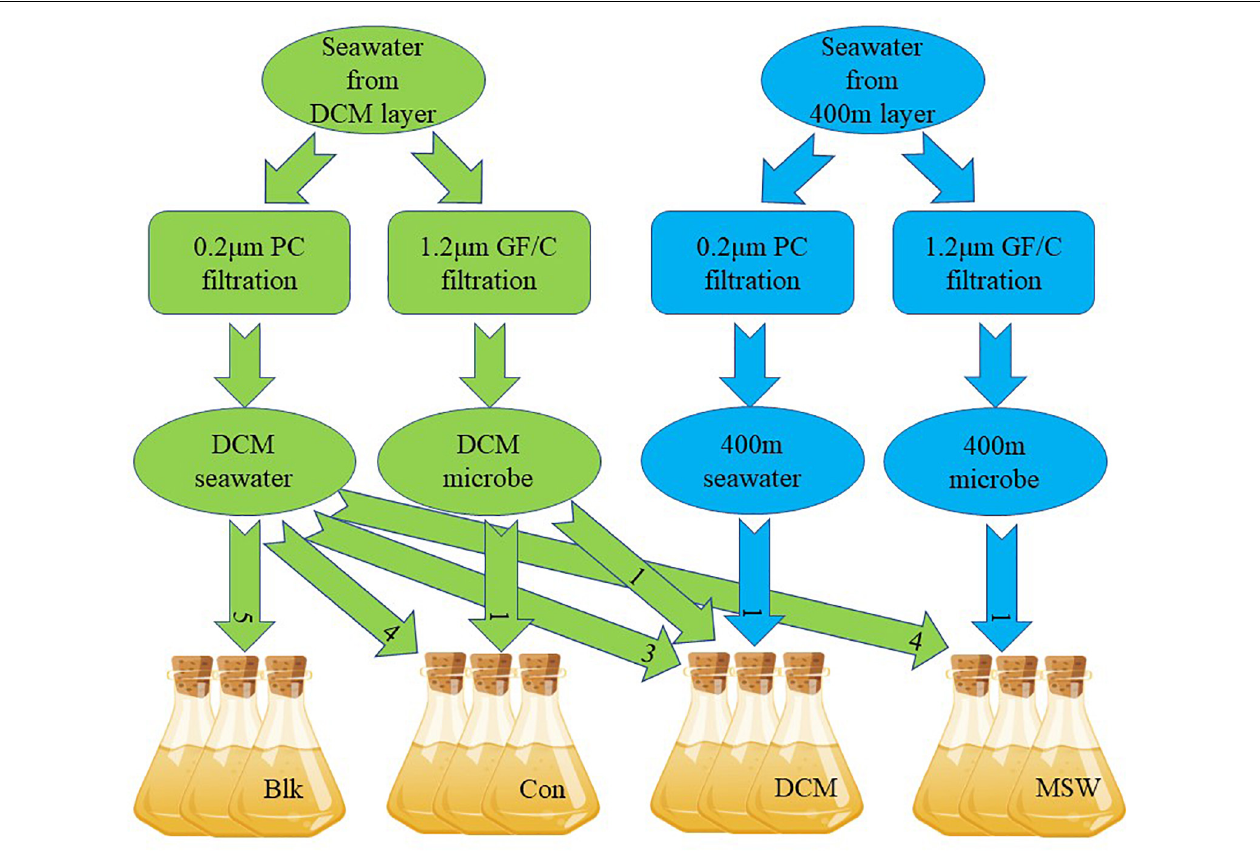
FIGURE 2 | Simulation of the water mixing cultivation experiment. DCM seawater means DCM seawater filtered through a 0.2 µ m polycarbonate filter, DCM microbe means DCM seawater filtered through a 1.2 µ m glass microfiber filter, 400 m seawater means 400 m seawater filtered through a 0.2 µ m polycarbonate filter, 400 m microbe means 400 m seawater filtered through a 1.2 µ m glass microfiber filter. Each culture system was 4.5 L in volume, and three parallel experiments were conducted. Seawater and microbes were always mixed in a 4:1 ratio. Blk was checked for the removal of microorganisms from seawater. The number in the arrow represents the mixing ratio. All experiments were performed at 18 ◦ C in the dark for 24